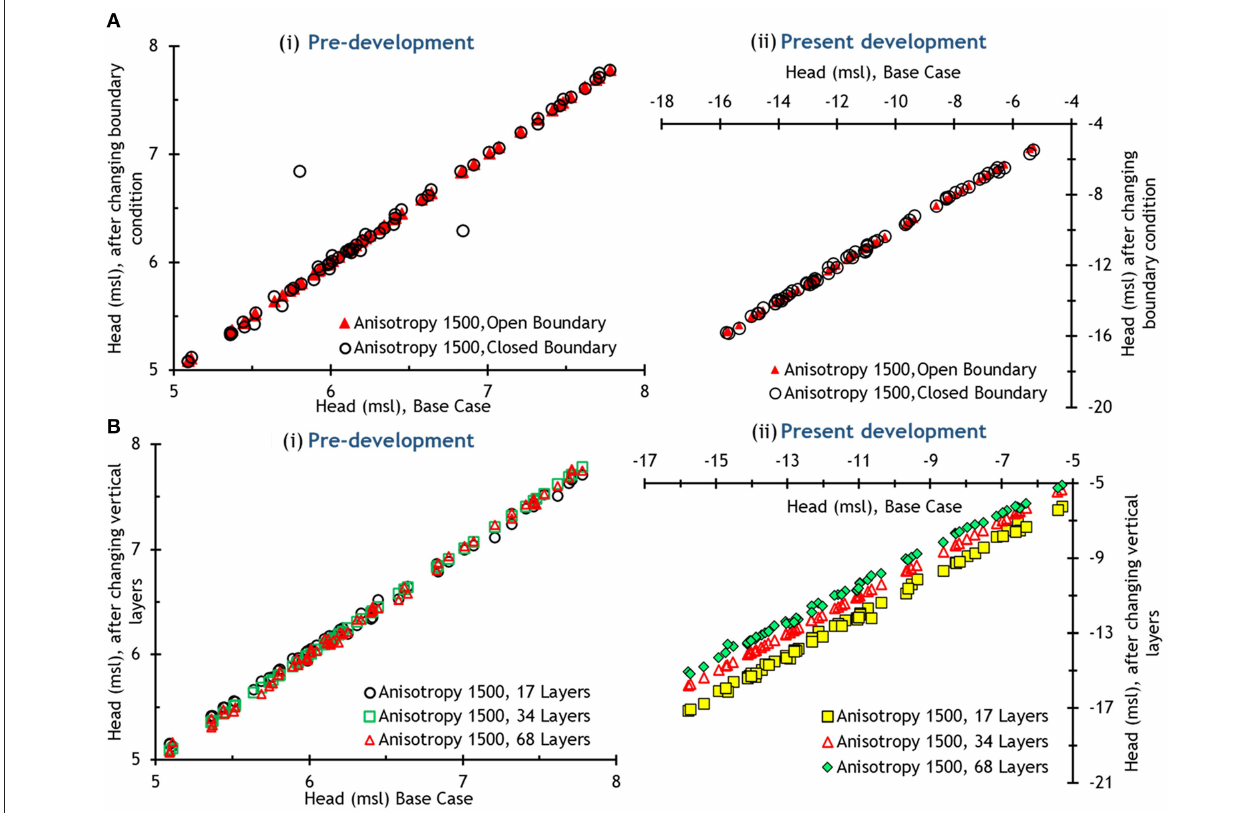
FIGURE 6 | (A) The change of the heads of GWLMS with the change of boundary conditions under (i) predevelopment and (ii) present development conditions. (B) The change of the heads of GWLMS with the change of vertical discretization under (i) predevelopment and (ii) present development conditions.